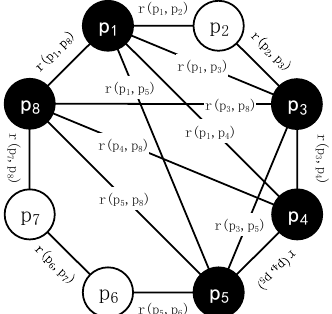
Figure 3. Undirected weighted DAEN model.